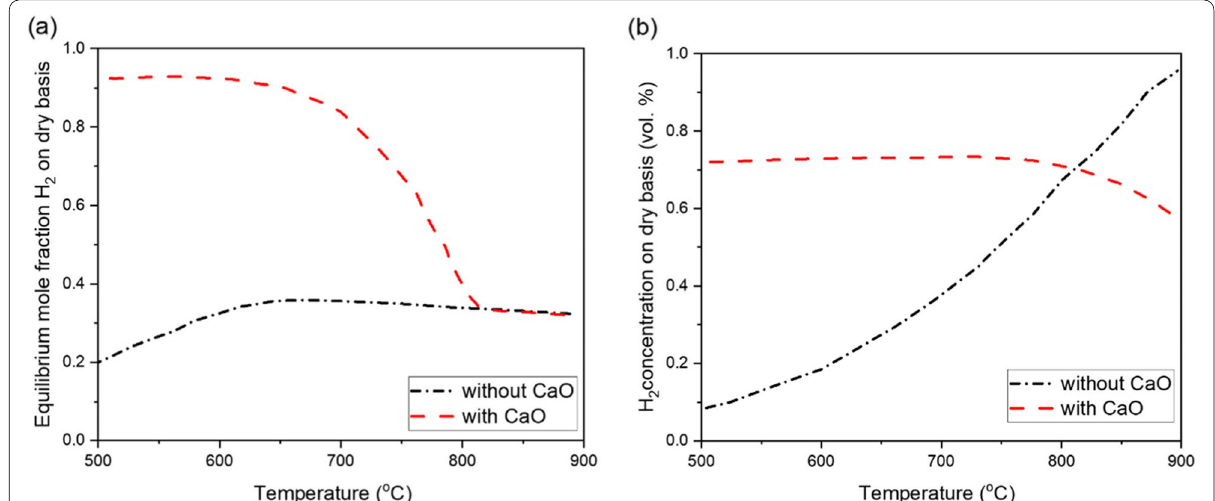
Fig. 8 The production of H 2 as a function of temperature with 1 mol CaO (red dash line) and without (black dash dot line) predicted by thermodynamic equilibrium modelling, a mole fraction of H 2 , inputs: 1 mol CO, 1 mol H 2 O; b product gas concentration of H 2 at 15 bar pressure, inputs: 1 mol CH 4 , 1 mol CO, and 2 mol H 2 O [37,